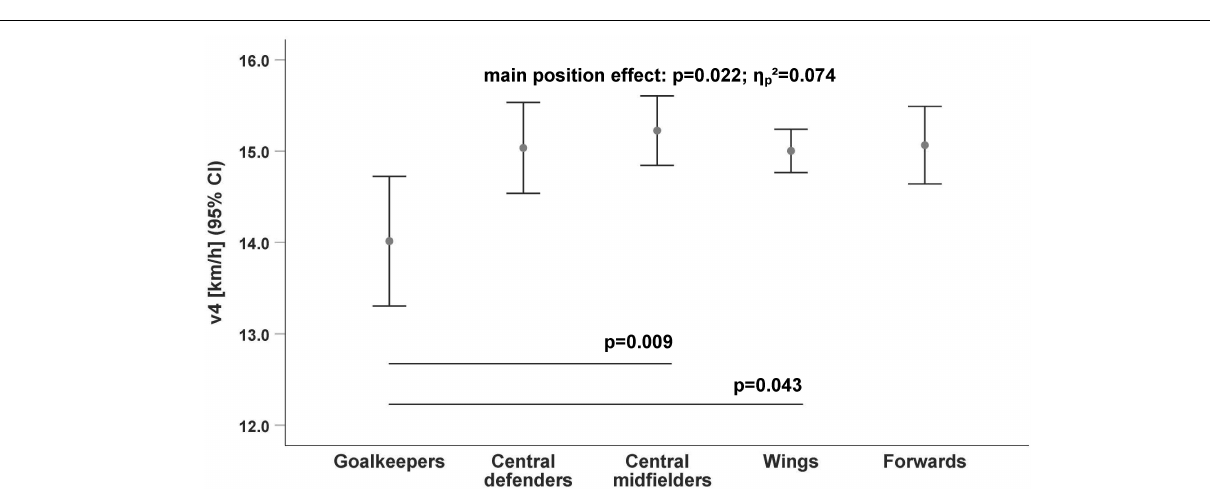
FIGURE 2 | Differences in running velocity by playing position at the 4 mmol/l lactate threshold (v4). Cl, Confidence